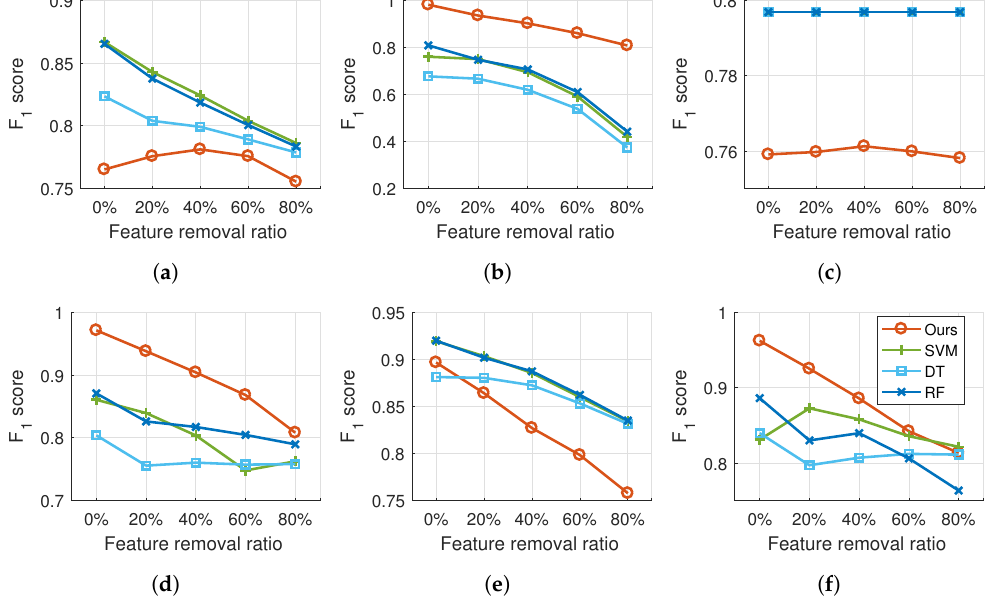
Figure 8. Performance results of the proposed model and comparison methods evaluated by F 1 score for the second set of experiments. ( a ) Experiment 2s (F 1 ). ( b ) Experiment 3s (F 1 ). ( c ) Experiment 4s (F 1 ). ( d ) Experiment 5s (F 1 ). ( e ) Experiment 6s (F 1 ). ( f ) Experiment 7s (F 1